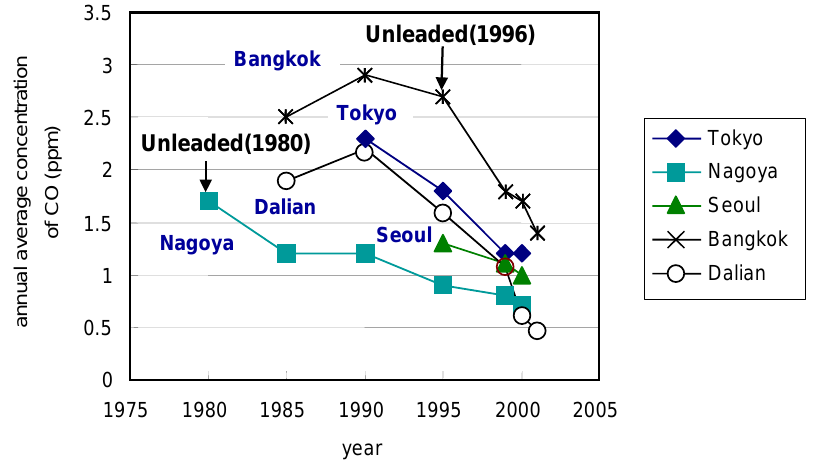
Figure 9. Effect of the use of unleaded gasoline on CO emission While many Asian countries have adopted European emission standards for cars and trucks as shown in Table 3, they do not adopt similar standards for fuels. For example, Beijing is scheduled to introduce EURO2 in 2003; however, fuel quality is some way behind European standards. Project cooperation of the German Federal Environmental Agency, with Malaysia and Indonesia revealed a similar situation (OECD 2003). These lessons stress the need to develop and deploy different policy instruments according to each country's social and economic